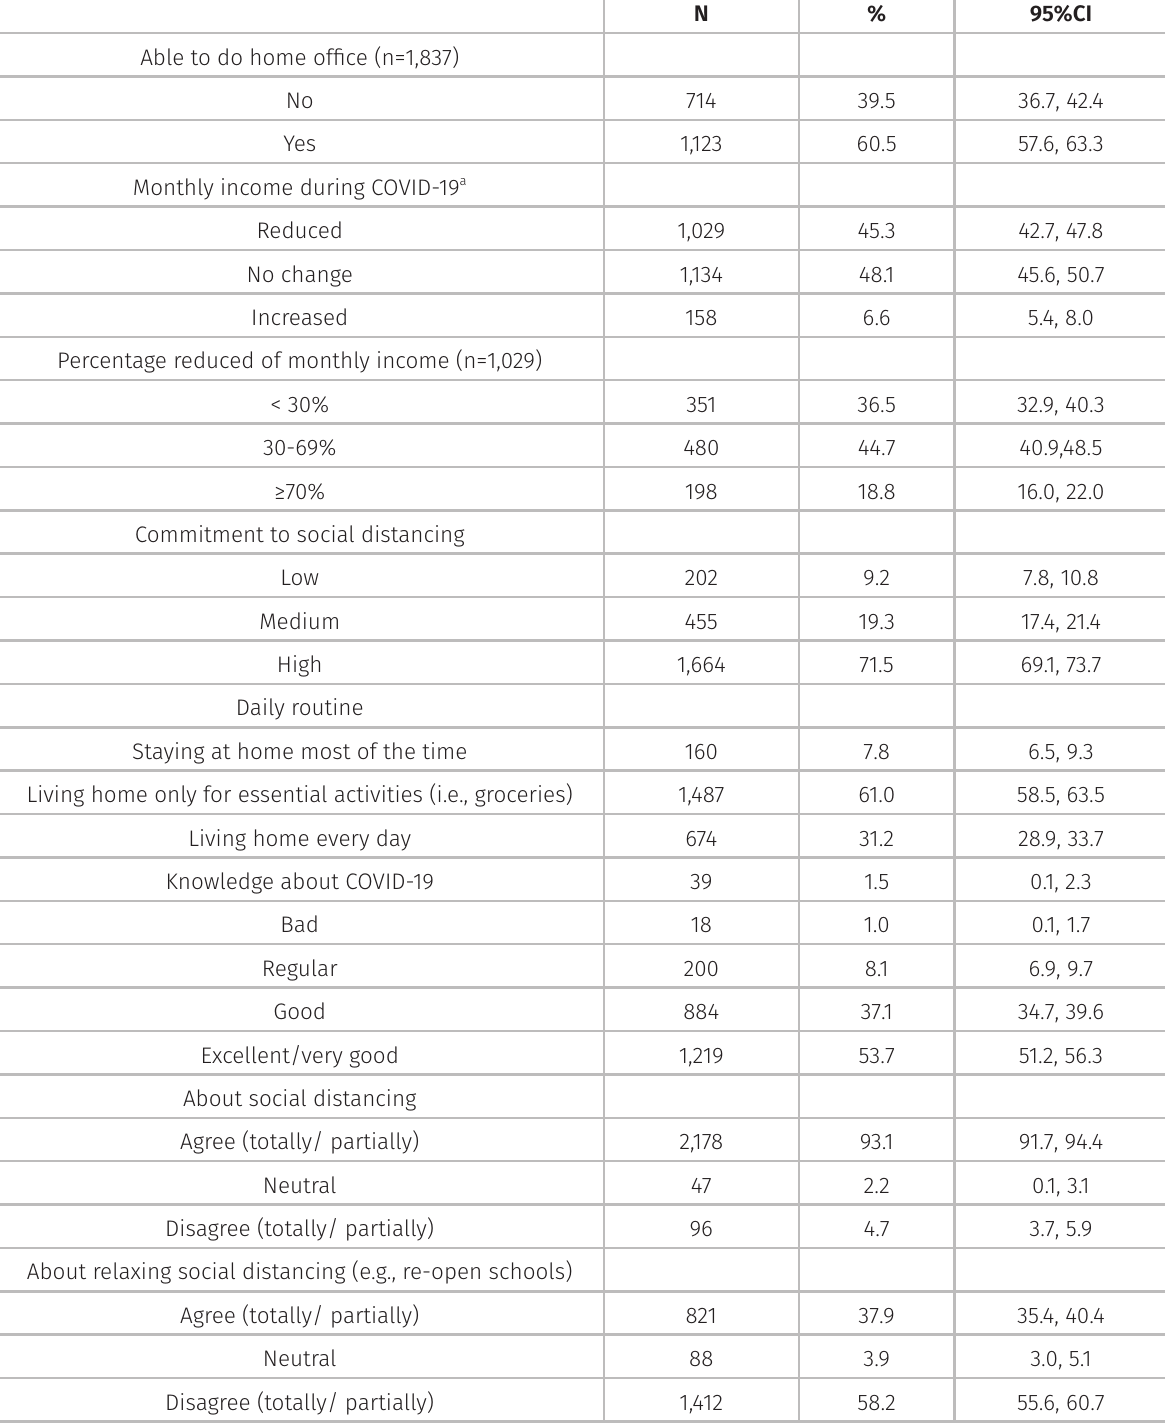
Table II. Knowledge and attitudes on COVID-19 pandemic in the included participants. Rio Grande do Sul, Brazil. N=2,321. CI: confidence